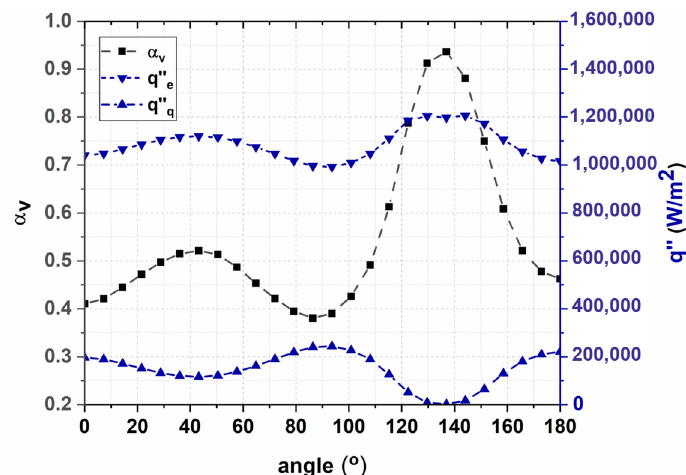
Figure 10. Azimuthal variation of near-wall void fraction, evaporative heat flux, and quenching heat flux at axial DNB location (1.48 m) for case-1 at 1.14 MW/m 2 .